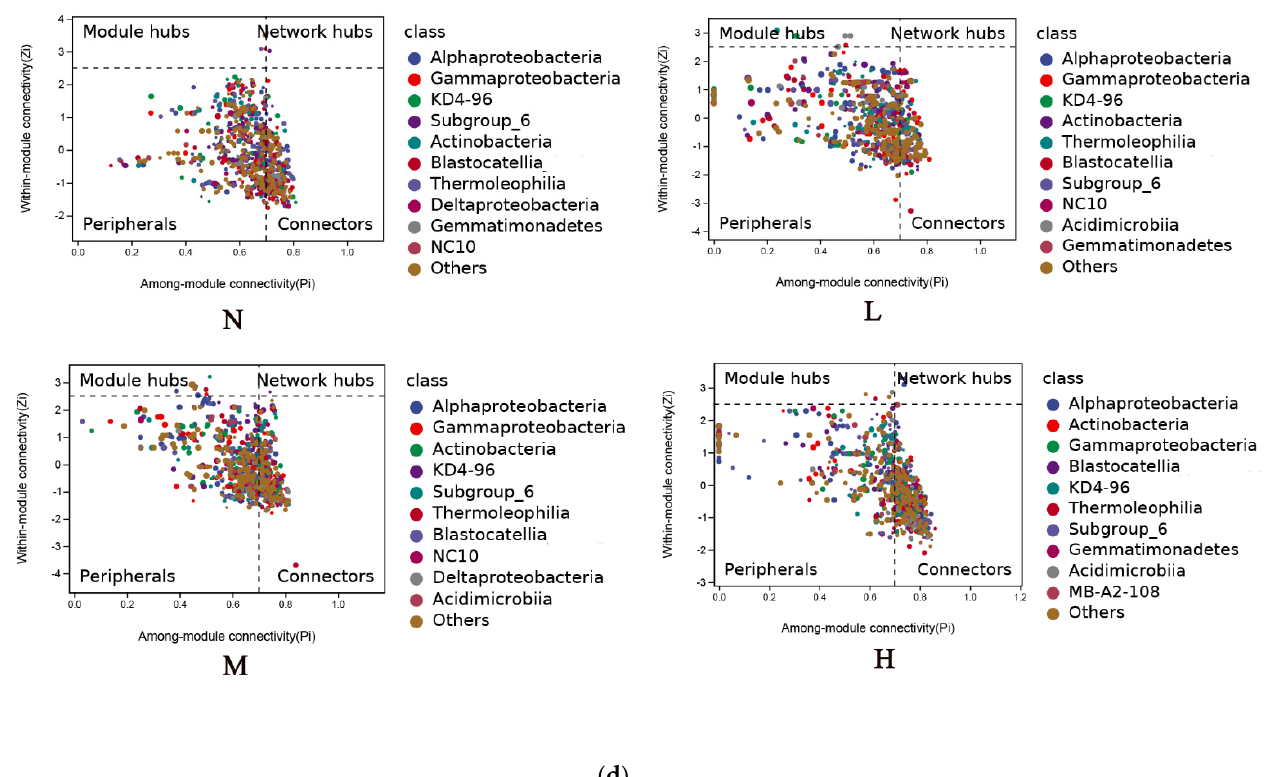
Figure 3. The effects of L. principis-rupprechtii regeneration degree on soil bacterial structures and diversities. ( a – c ) Network of soil bacterial populations among different L. principis-rupprechtii regen- eration degree. Red lines indicate positive correlations and green lines indicate negative correlations. The area of the node is proportional to node degree, calculated from correlations of abundances for each ASV. Only correlations with an r of >0.6 or <0.6 and a p value of <0.05 were included in the network. ( d ) Topological roles of ASVs in the soil bacterial co-occurrence networks in four regeneration degrees as indicated by the Zi-Pi plot. The nodes with Zi > 2.5 are identified as module hubs, and those with Pi > 0.62 are connectors. The network hubs are determined by Zi > 2.5 and Pi > 0.62, and the peripherals are characterized by Zi < 2.5 and Pi < 0.62.